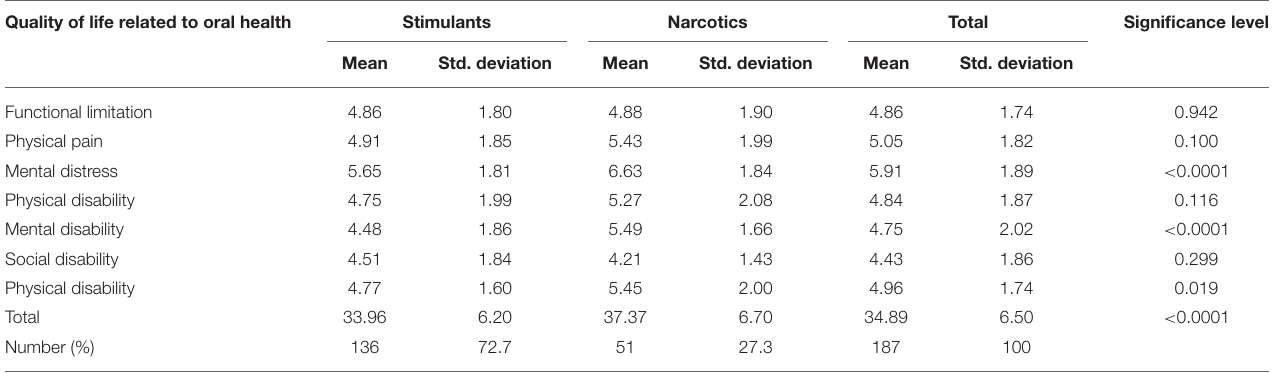
TABLE 2 | Mean scores of qualities of life related to oral health of addicts wise. Quality of life related to oral health Stimulants Narcotics Total Significance level Mean Std. deviation Mean Std. deviation Mean Std.